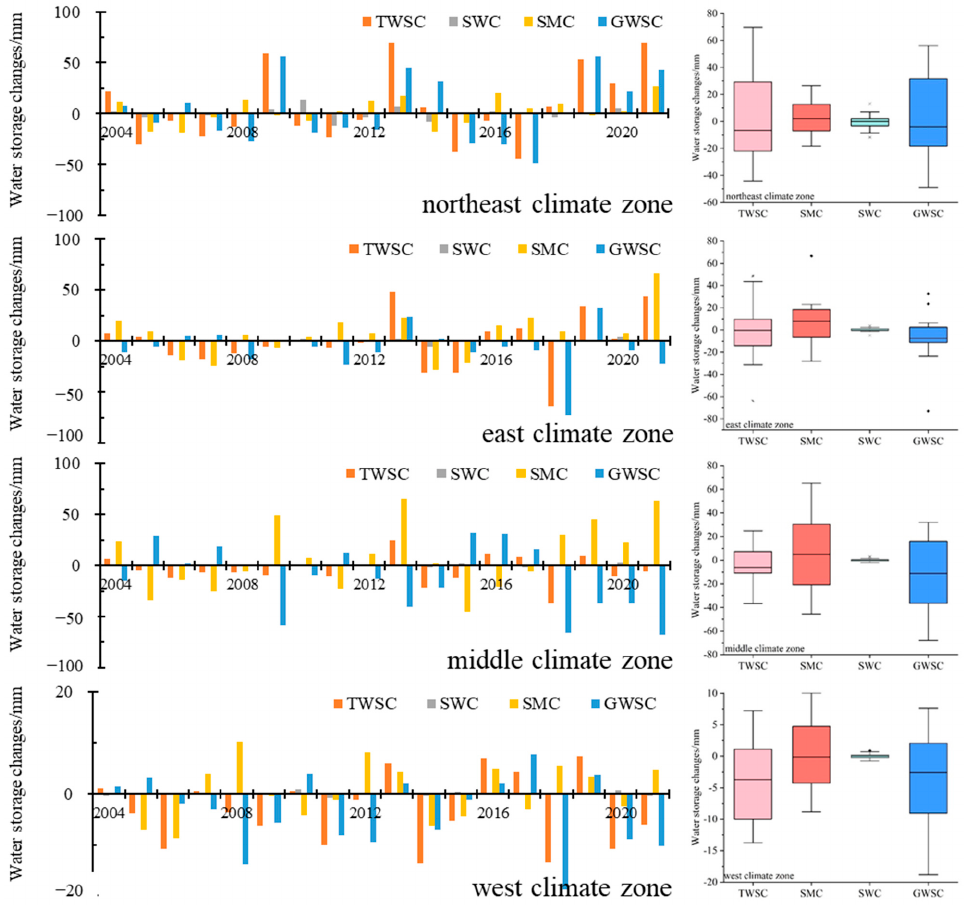
Figure 5. Time series and box diagram of TWS changes with its hydrological components (TWSC: TWS changes; SMC: Soil moisture changes; SWC: Surface water changes, the sum of SWE and CanoInt; GWSC: Groundwater storage changes). (The asterisk in the box diagram is the outlier)